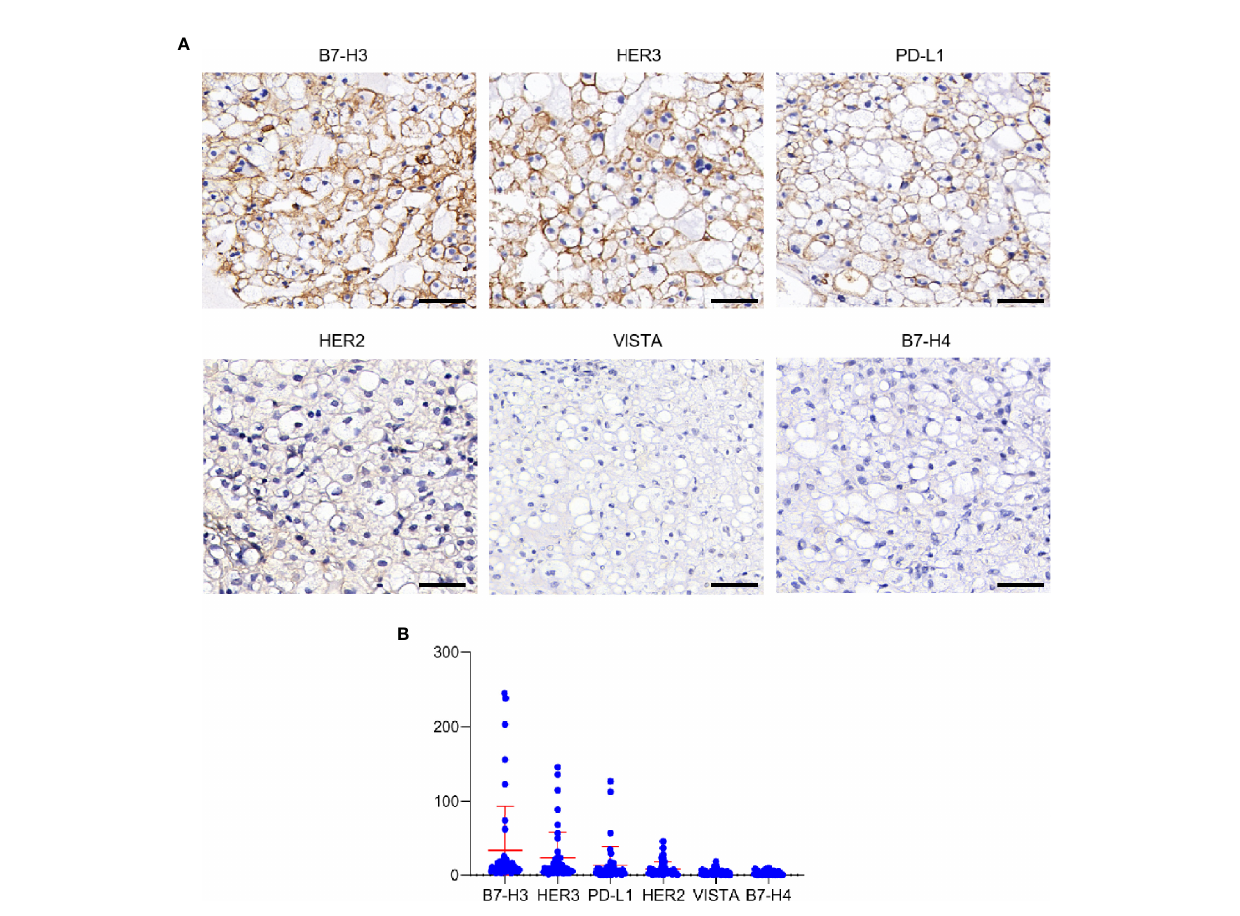
FIGURE 1 | Expression analysis of target antigens in Chordoma. (A) Representative IHC staining images of different antigens, including B7-H3, HER3, PD-L1, HER2, VISTA and B7-H4. Scale bar: 50 m m. (B) Histoscore (H-score) of tumor sections (evaluated by pathologist blinded to tumor antigens and expression